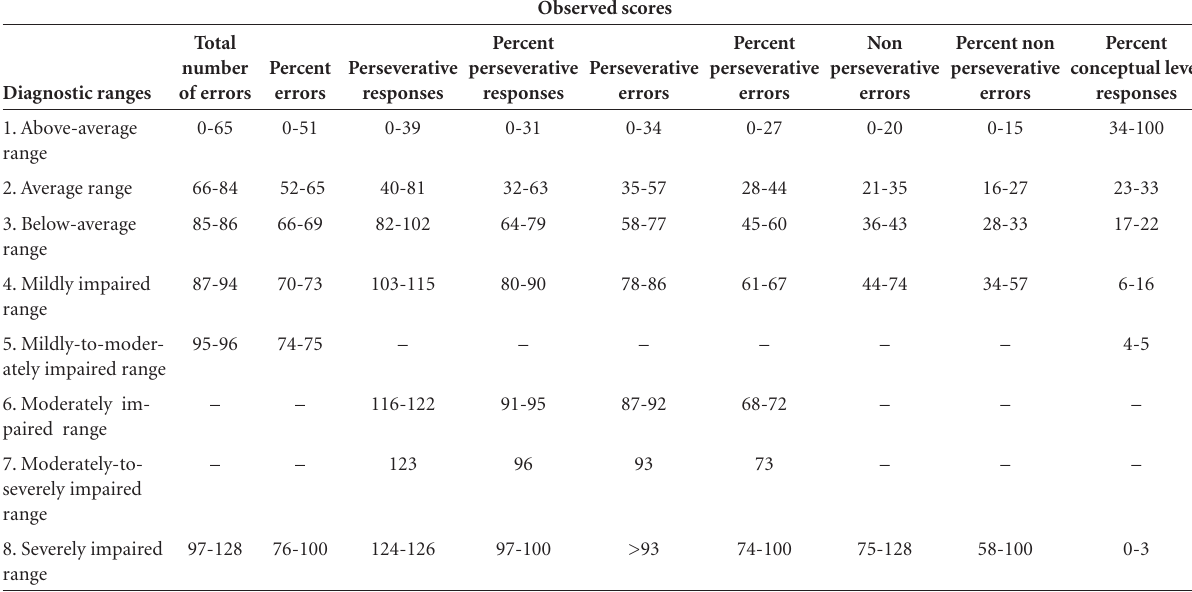
Table 3. Preliminary assessment norms for the WCST in elderly persons with initial stage of AD (n=36).